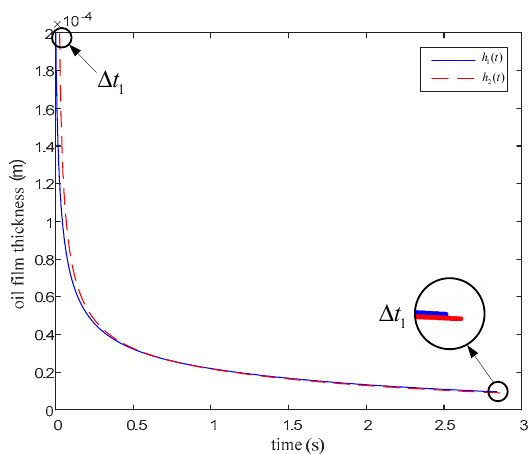
Figure 9. Curve of oil film thicknesses h 1 ( t ) and h 2 ( t ).